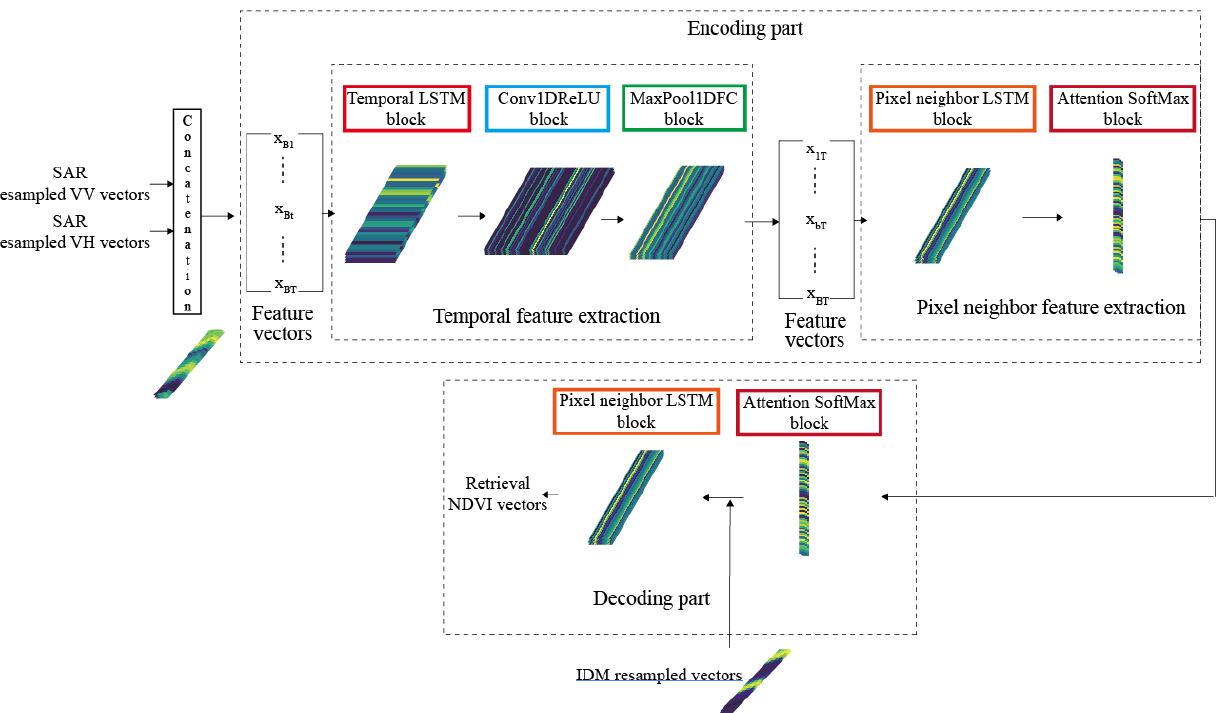
Figure 4. Input resampling workflow. The double-attention RNN resamples the input pixel vectors with step B to enlarge the analyzing dimensions of the feature extraction to the temporal and pixel neighbor domains. The black grids represent N pixels in T time phases and the two red grids at the bottom of the figure are pixels to be resampled; the red pixel vectors on top of the figure are the resampled feature vectors with step B .